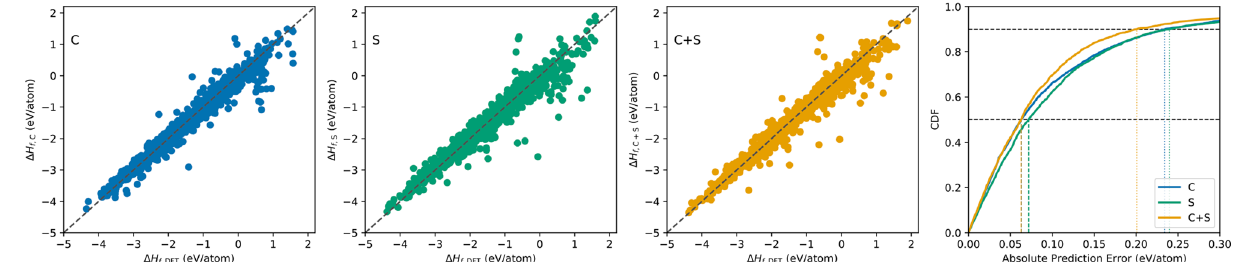
Figure 4. Prediction error analysis for formation enthalpy in JARVIS using different model input for 17-layer IRNet. We use the prediction errors on the hold-out test set using a random 9:1 train:test split. The first three subplots represent the prediction errors on the hold-out test set using three different model inputs for IRNet: C (composition-derived 145 physical attributes), S (126 structure-derived attributes using Voronoi tesselation) and C+S (145 physical attributes+126 structural attributes); the last subplot contains the CDF of the prediction errors for the three model inputs for